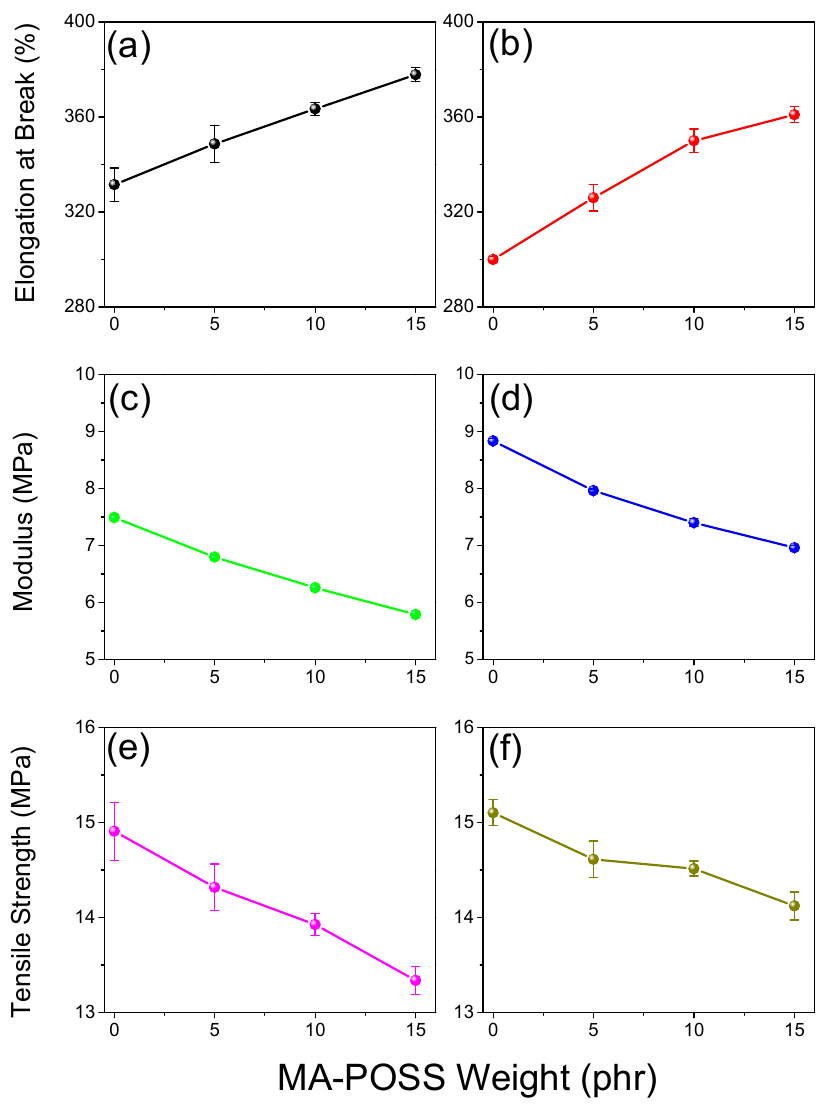
Figure 9. Mechanical properties of PVC/DINCH/MA-POSS blends at various MA-POSS contents ( a , c , e ) before and ( b , d , f ) after thermal annealing at 100 °C for 7 days: ( a , b ) elongation properties, ( b , d ) moduli, and ( c , f ) tensile strengths.